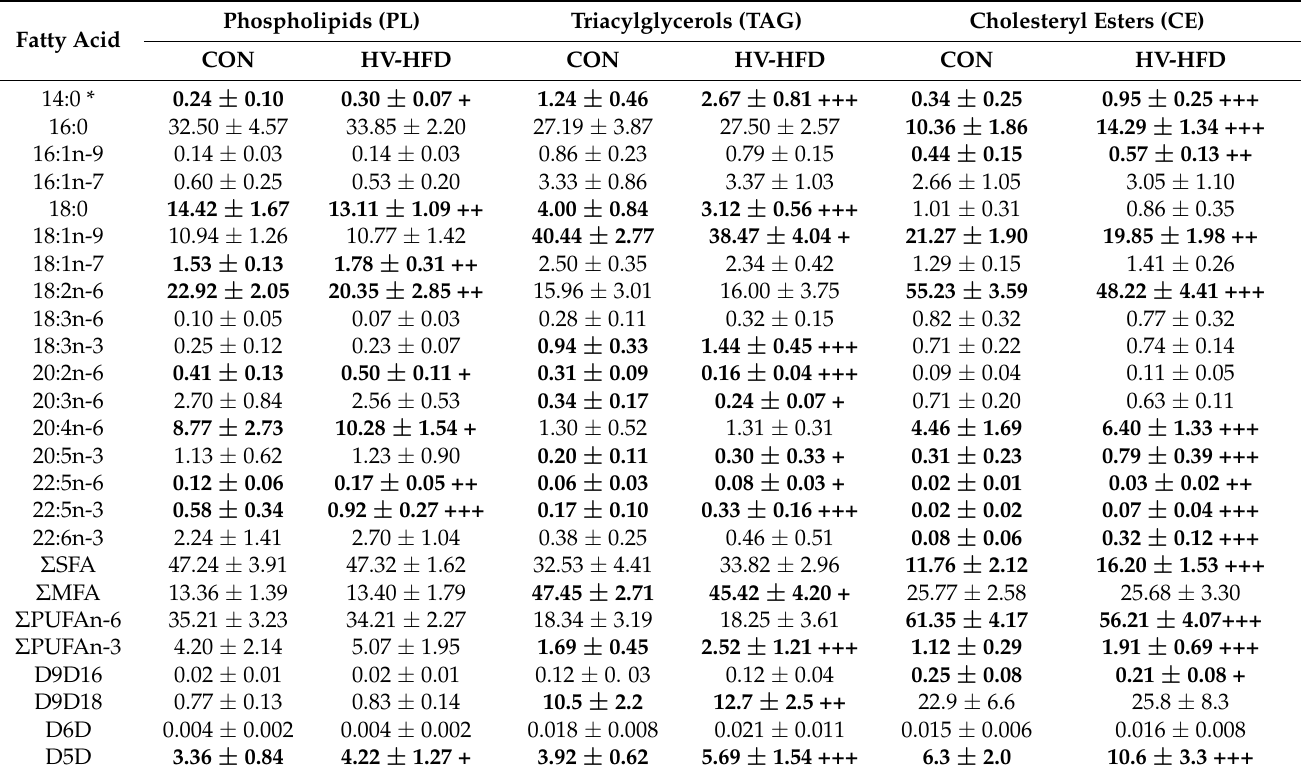
Data (molar percentages) are given in average ± SD format. Symbols and abbreviations: * shorthand notation for fatty acids: carbon number: double bond number, n—Position of carbon with first double bond from methyl end; FA—Fatty acids, ∑ —Sum, SFA—Saturated fatty acids, MFA—Monounsaturated fatty acids, n-6 PUFA—Polyunsaturated fatty acids of the n-6 family, n-3 PUFA—Polyunsaturated fatty acids of the n-3 family, D9D16—D9 desaturase for C16 (16:1n-7/16:0), D9D18—D9 desaturase for C18 (18:1n-9/18:0), D6D—D6 desaturase (18:3n-6/18:2n-6), D5D—D5 desaturase (20:4n-6/20:3n-6); significant difference (ANCOVA adjusted for age and BMI) from the non-HV-HDF group: + p < 0.05; ++ p < 0.01; +++ p < 0.001. The differences are highlighted in